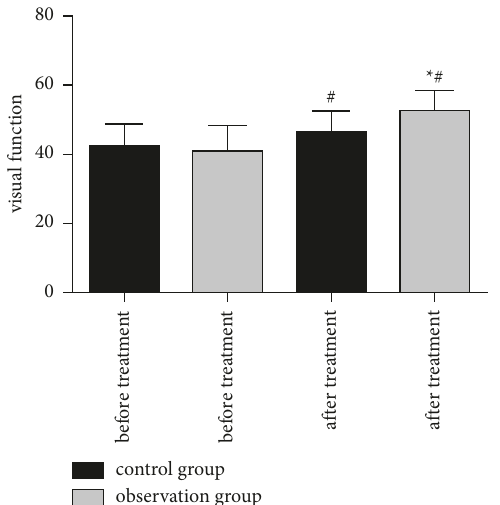
Figure 10: The social activity scores of the two groups of patients at different times.Note: Compared with the same group before treatment, # ∗ P < 0 . 05; compared with the control group, ∗ P < 0 . 05.